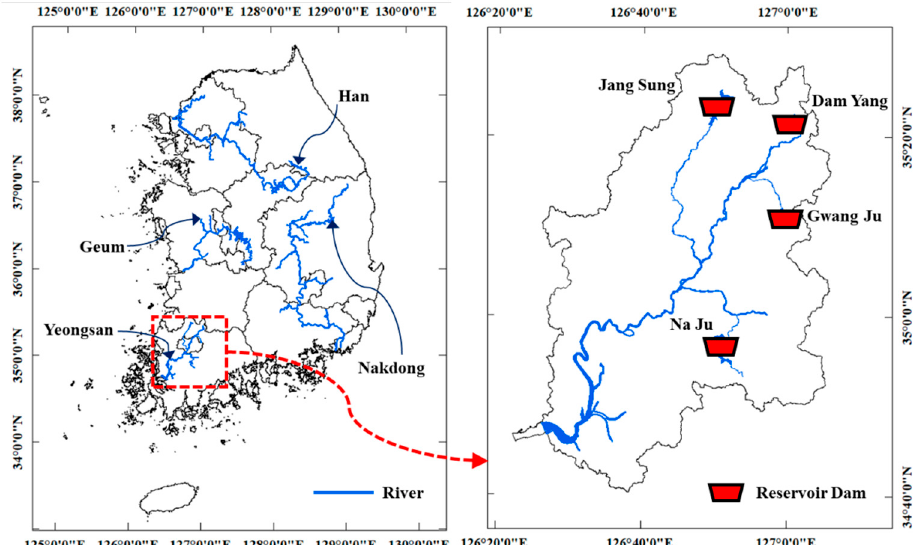
Figure 2. Locations of the study watersheds and the four major rivers in South Korea. Table 1. Specification of the study reservoirs and their expected capacity for EF supply. Items Naju Jangsung